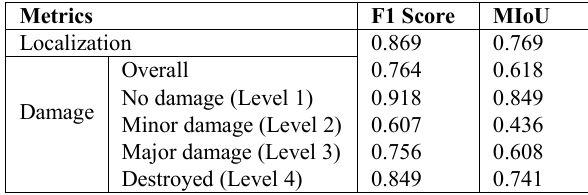
Table 4. F1 score and MIoU of the model on test set